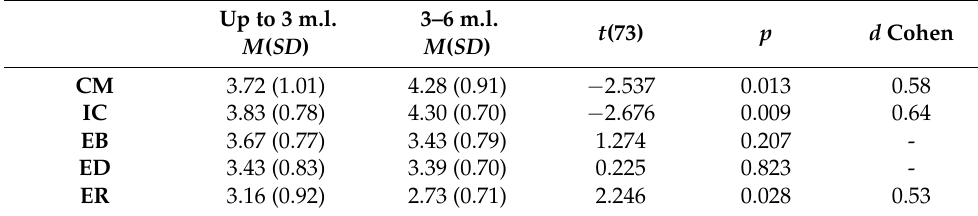
Table 10. The differences in identity among first-time mothers taking into consideration the age of children.